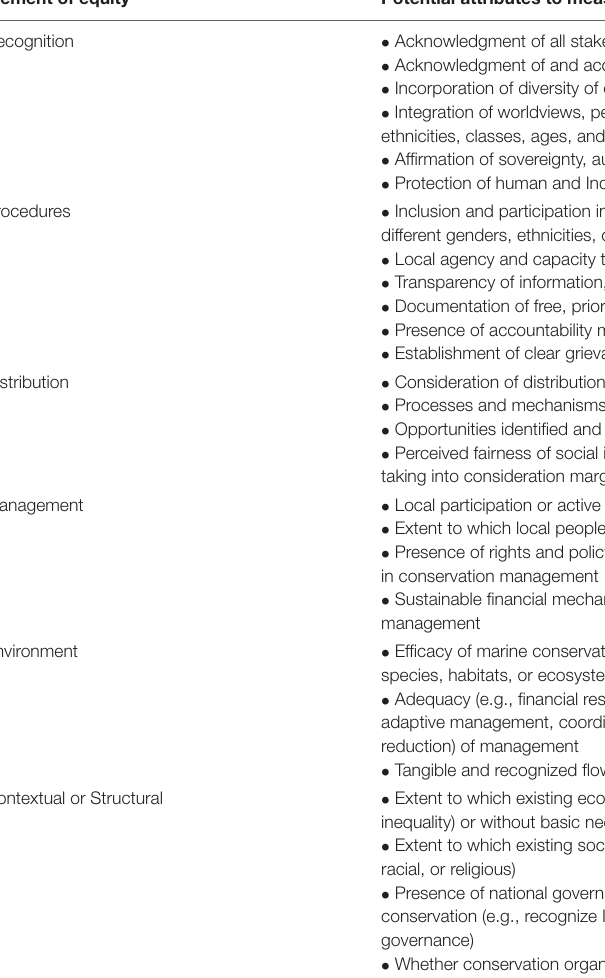
TABLE 2 | Potential attributes to measure the elements of social equity in marine conservation (building on Schreckenberg et al., 2016; Zafra-Calvo et al., 2017; Bennett et al., 2020; Engen et al., 2021). Element of